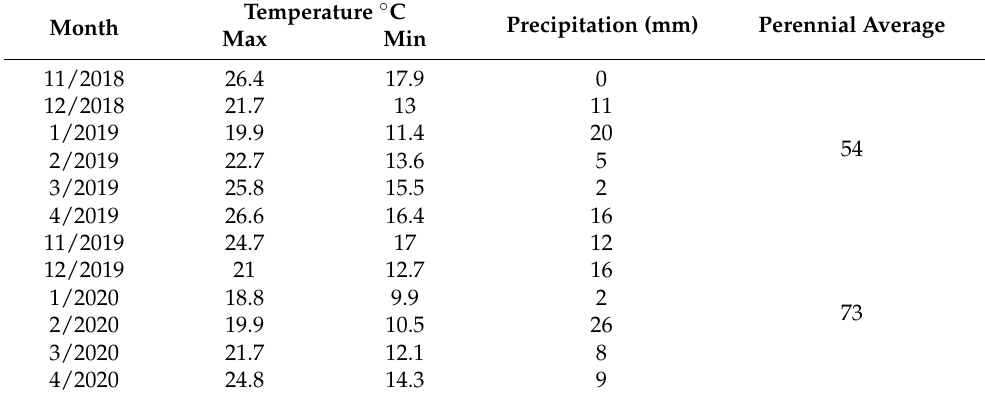
Table 2. Meteorological conditions of the experimental site in seasons 2018/2019 and